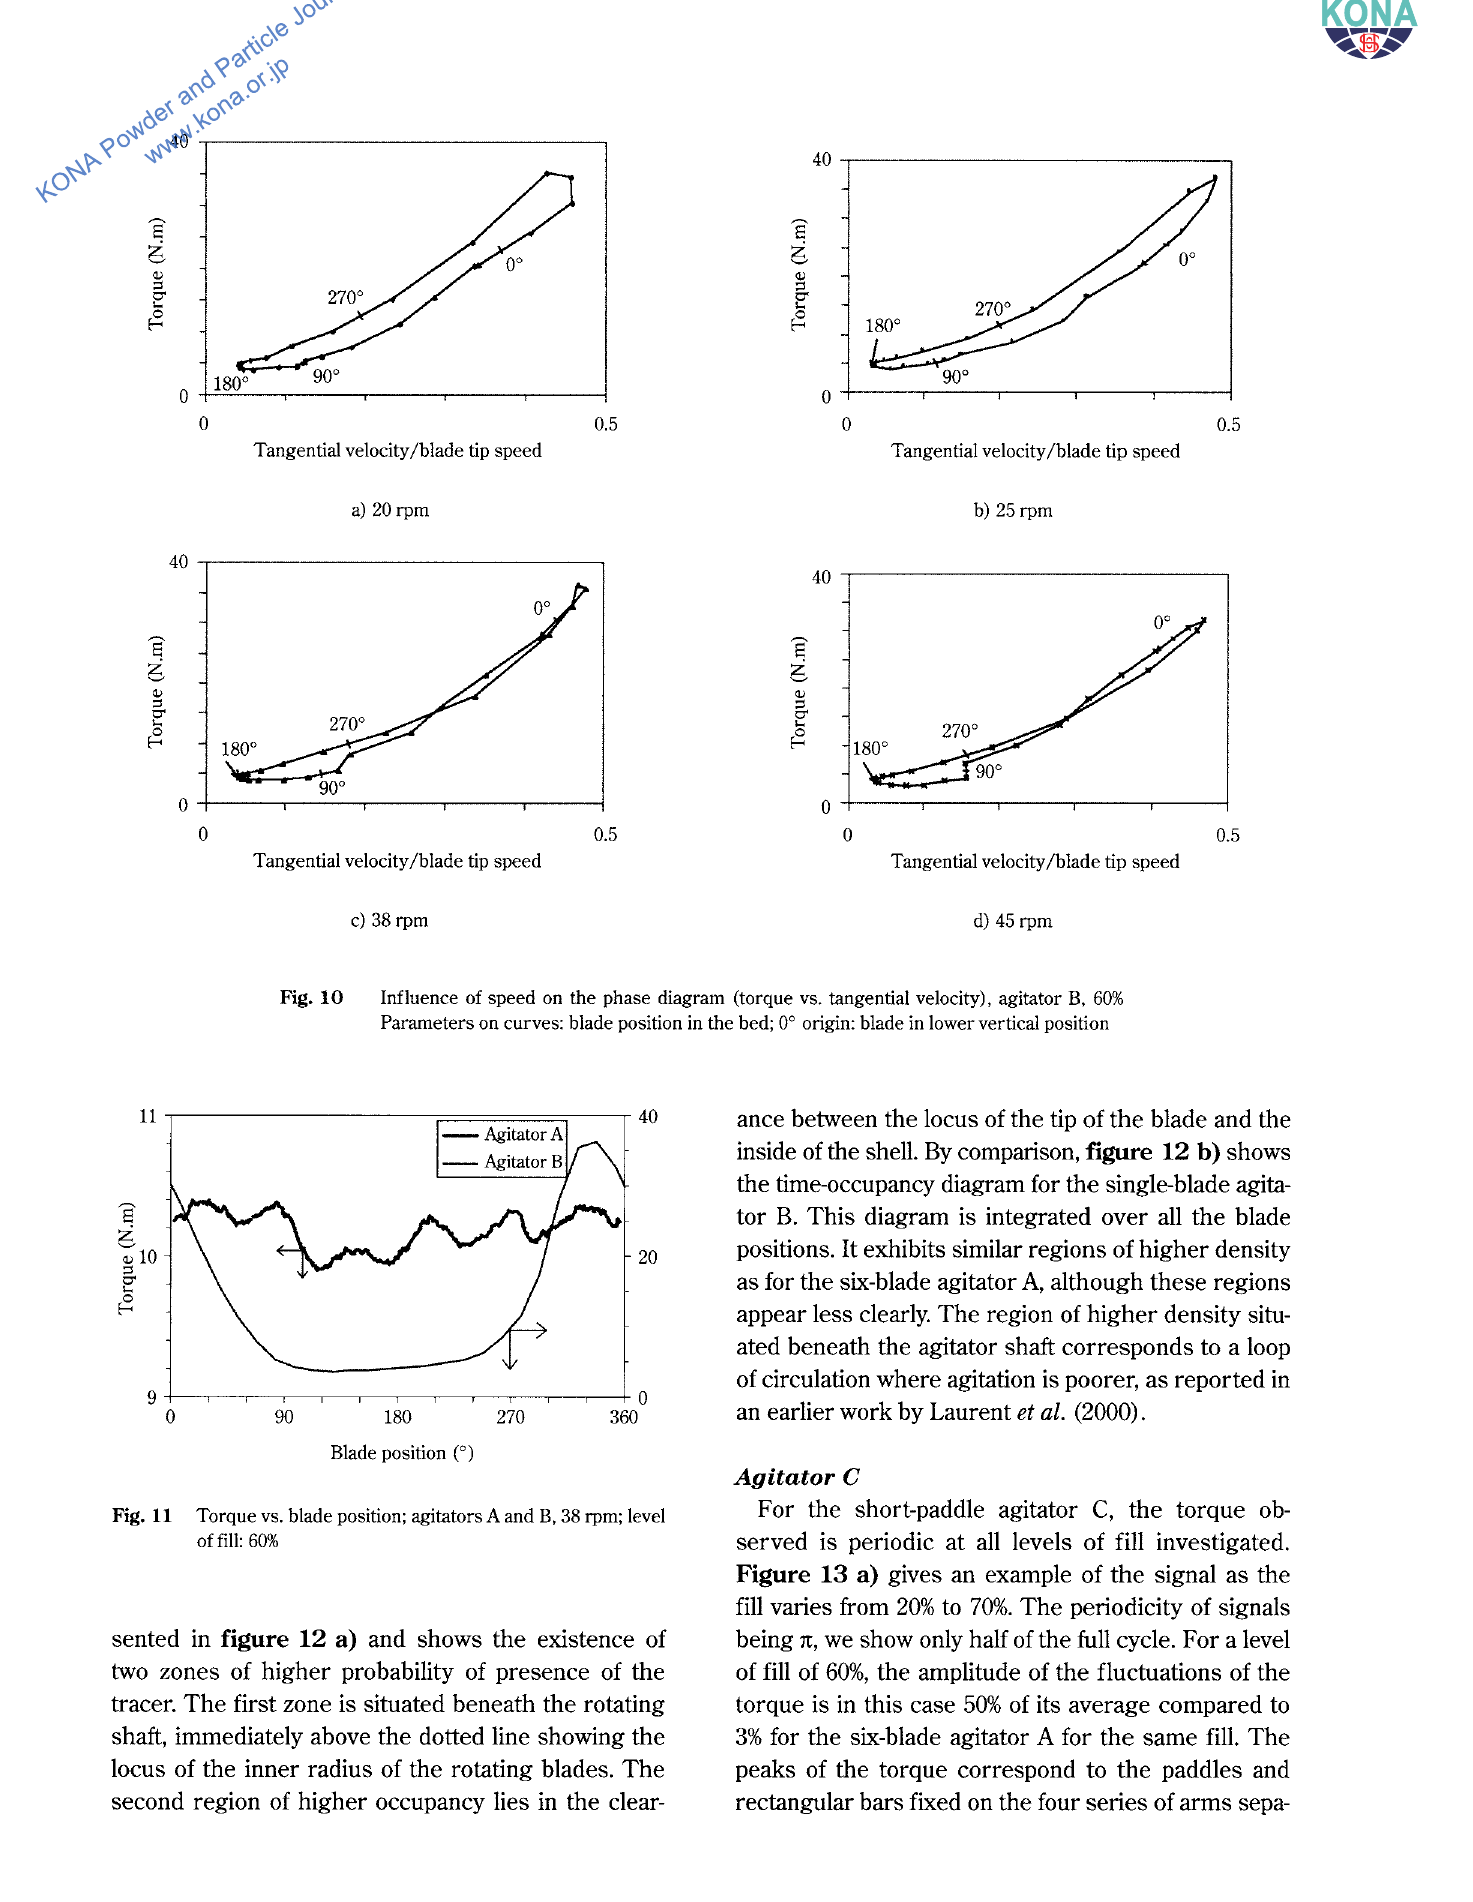
Fig. 11 Torque vs. blade position; agitators A and B, 38 rpm; level of fill: